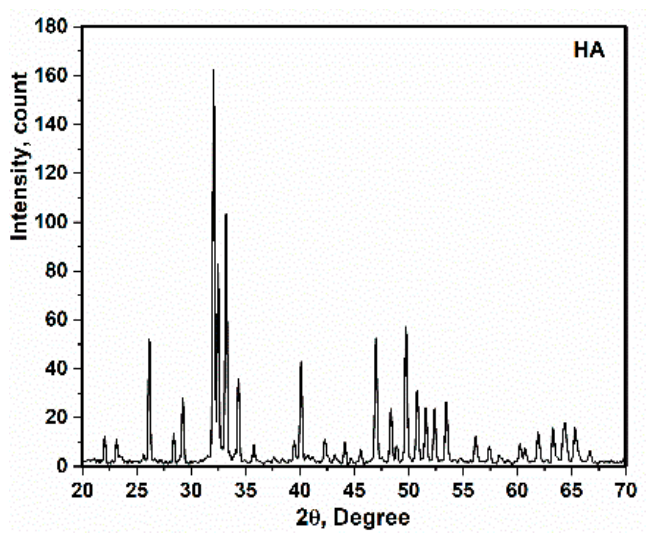
Figure 2. X-ray diffraction of HA.